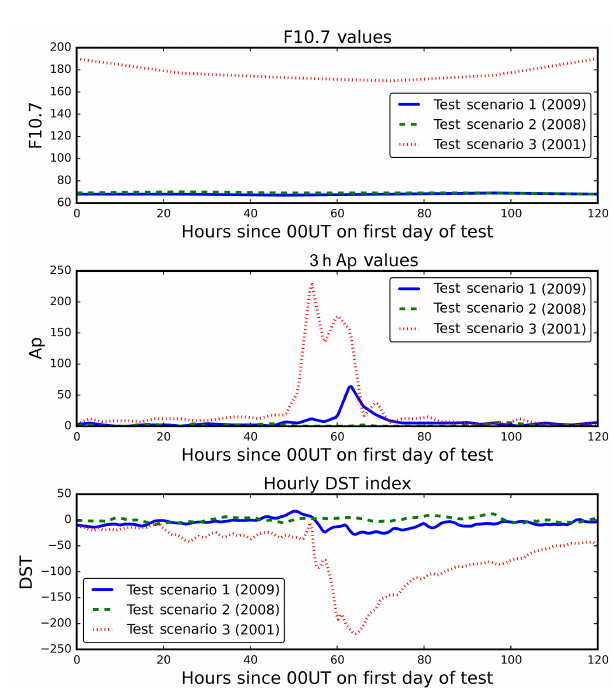
Figure 1. Ap, F10.7, and DST index values for the three test sce- narios. The spikes in Ap for the 2009 and 2001 test scenario seem to be due to a geomagnetic storms.